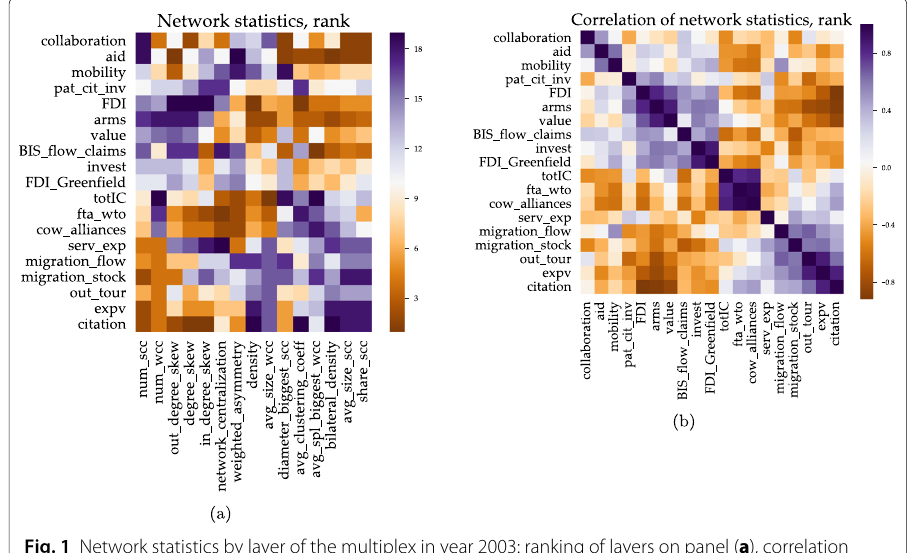
Fig. 1 Network statistics by layer of the multiplex in year 2003: ranking of layers on panel ( a ), correlation among rankings on panel ( b